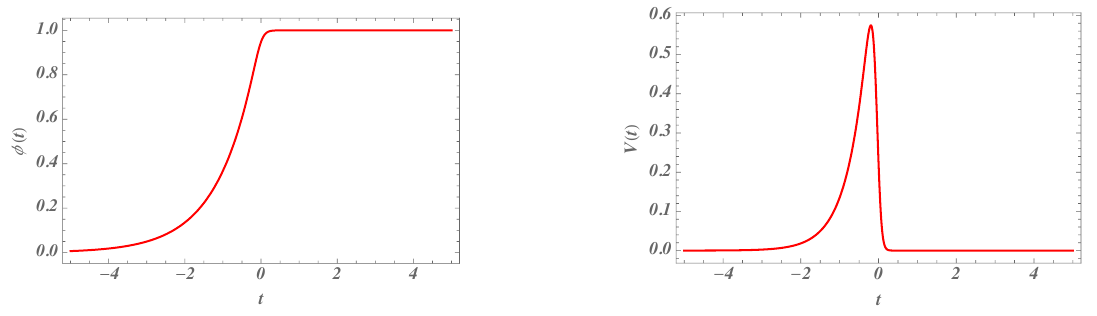
Figure 4 . Domain wall solution for SQCD with p = 15. In the right panel we plot the potential as a function of t